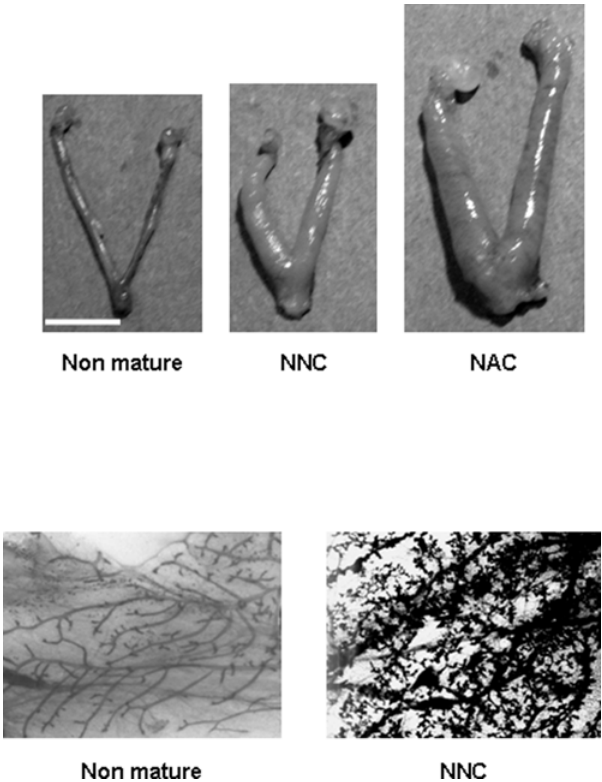
Figure 5. Representative macroscopic images of the uteri and mammary gland. Uterus of non-mature unmanipulated mouse is compared to those of non-pubertal mouse grafted with immature cortex (NNC), two months after transplantation and of pubertal mice grafted with immature cortex (NAC), six months after transplantation. All images are at the same magnification. Scale bar, 1 cm. Represen- tative whole mount of mammary glands from non mature mouse is compared to the mammary gland from a pre-pubertal mouse grafted with immature cortex (NNC) at mid pregnancy.